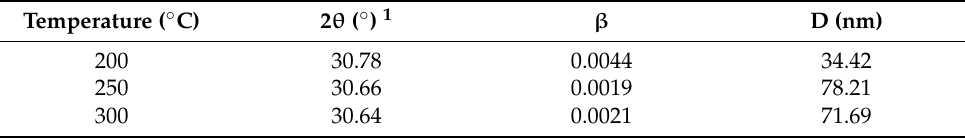
Table 1. Average crystallite size (D) of the ITO electrode on the SU-8 layer annealed at 200 ◦ C, 250 ◦ C, and 300 ◦